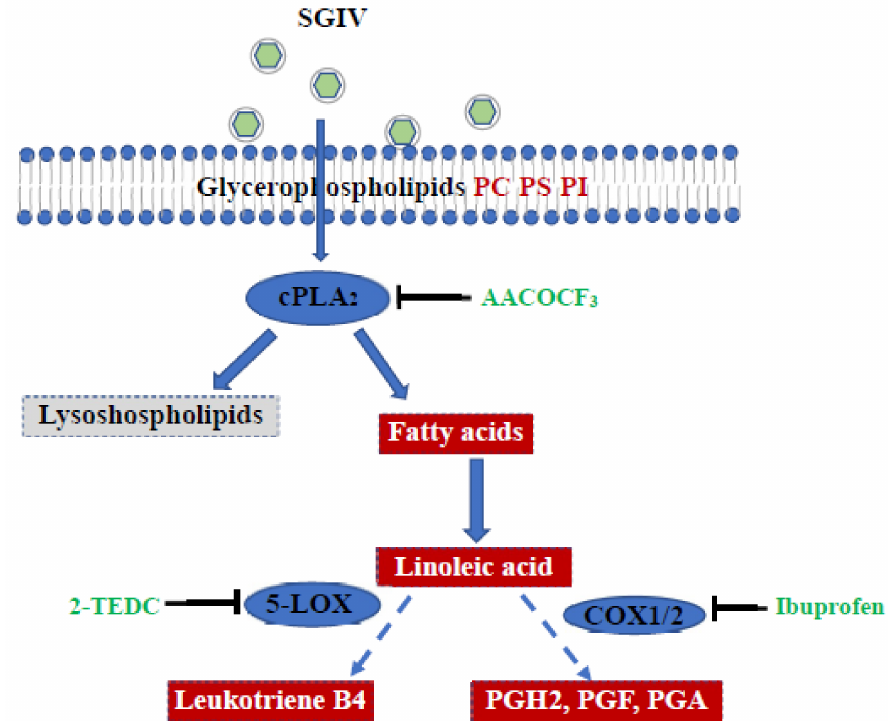
Figure 7. Model for the roles of cPLA2 and AA metabolism in SGIV infection. SGIV infection resulted in alteration of GPs homeostasis in vitro. Inhibition of cPLA2, COX, and 5-LOX significantly decreased SGIV replication. Inhibitors were shown in green. The key enzyme involved in GPs and AA metabolism were shown in blue. The lipid metabolites, which increased during SGIV infection, were shown in red. The lipid metabolites, which were not significantly changed in SGIV-infected cells, were shown in